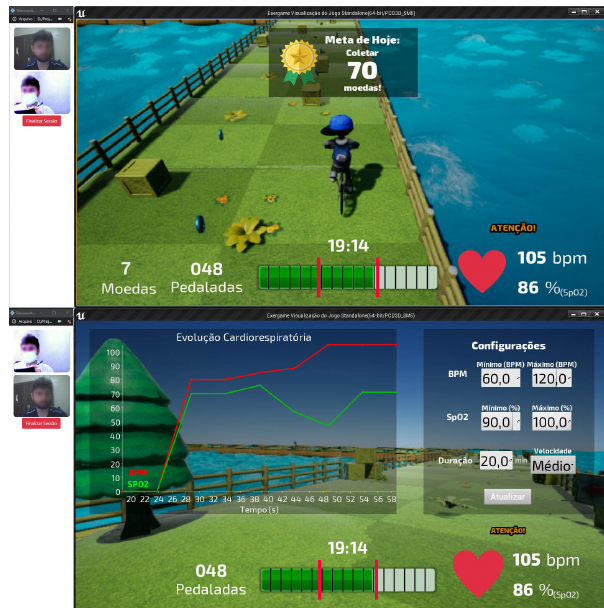
Figure3. Gamescreenshots(inPortuguese):patient(above)andphysiother- apist (below).